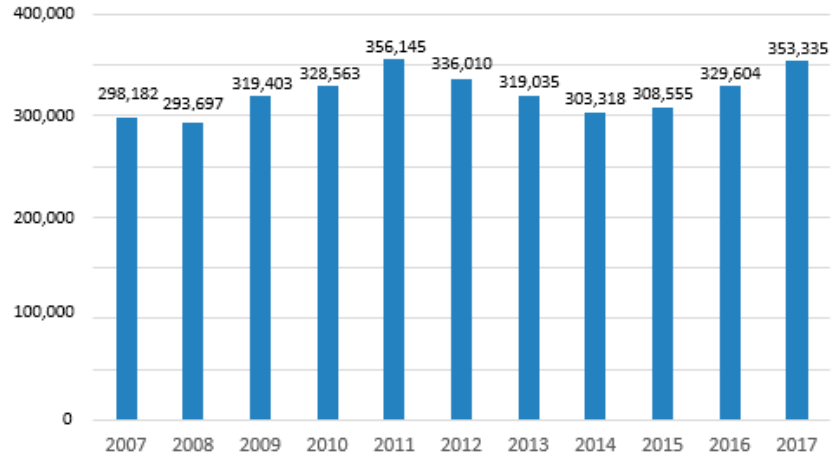
Figure 2. The number of passenger cars sold in Austria from 2007 to 2017 [45] (rendition by